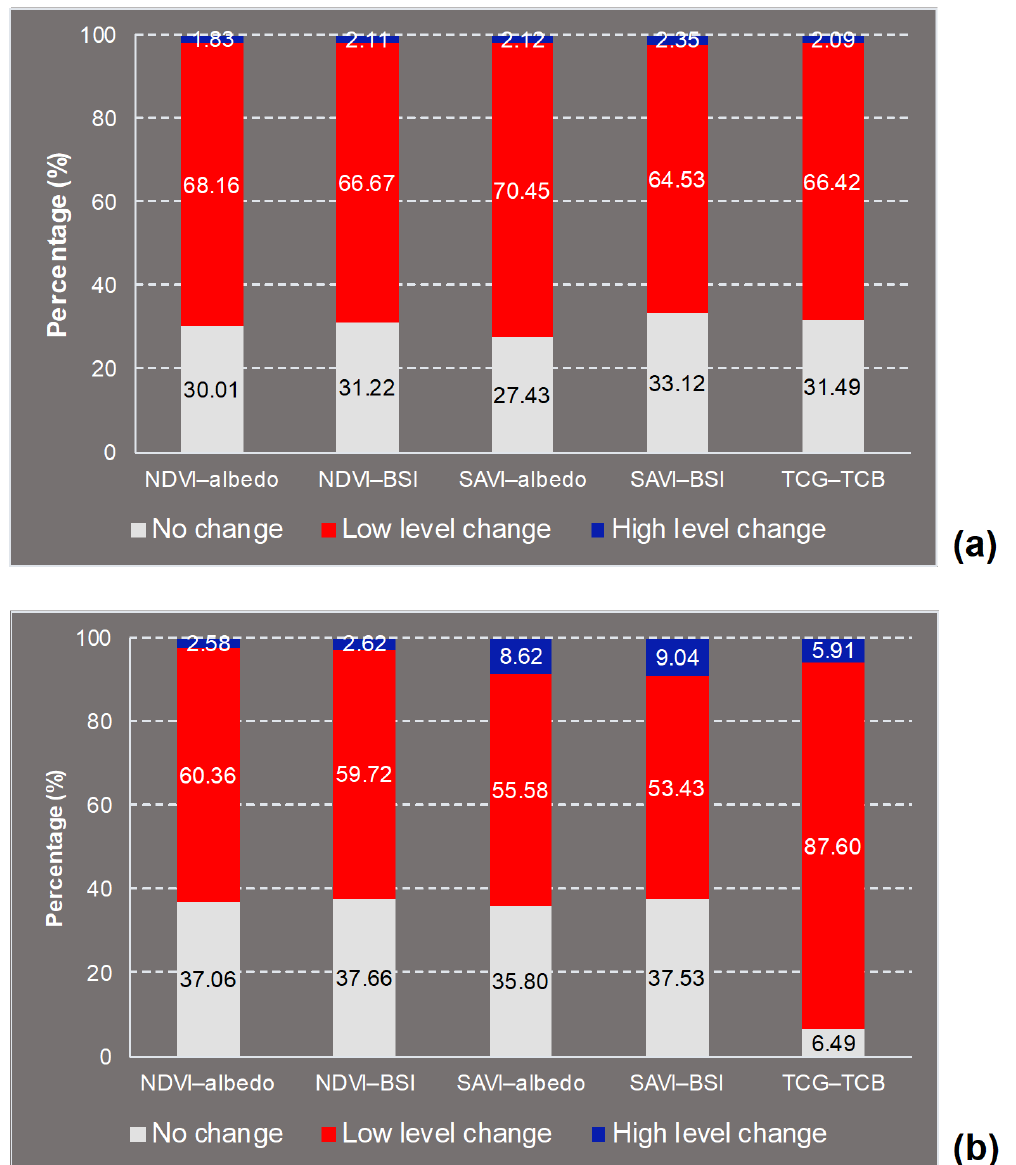
Figure 8. Area percentages of change magnitude categories produced by different index combinations: ( a ) 1999–2009; ( b ) 2009–2019.